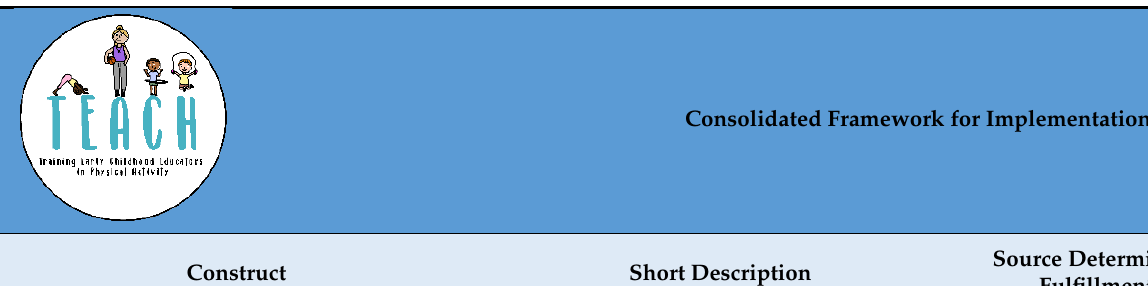
Table A1. Consolidated Framework for Implementation Research Construct Checklist for the TEACH Study.